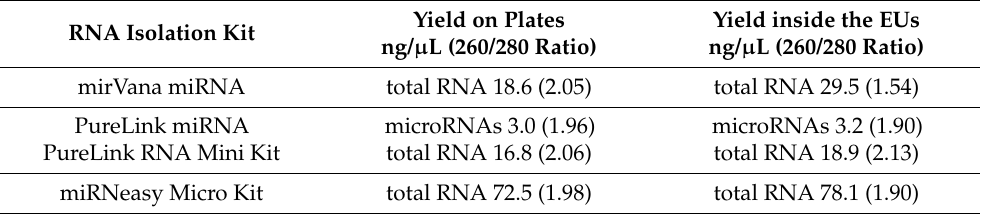
Table 4. RNA quantification from single Thermanox TM coverslip cultured in plates or EUs. Total RNA or microRNAs isolated using the indicated kits from huMPCs seeded on Thermanox™ coverslips and cultured either on plates or inside the EUs. Quantification was performed by a NanoDrop™ spectrophotometer. The average 260/280 ratios are